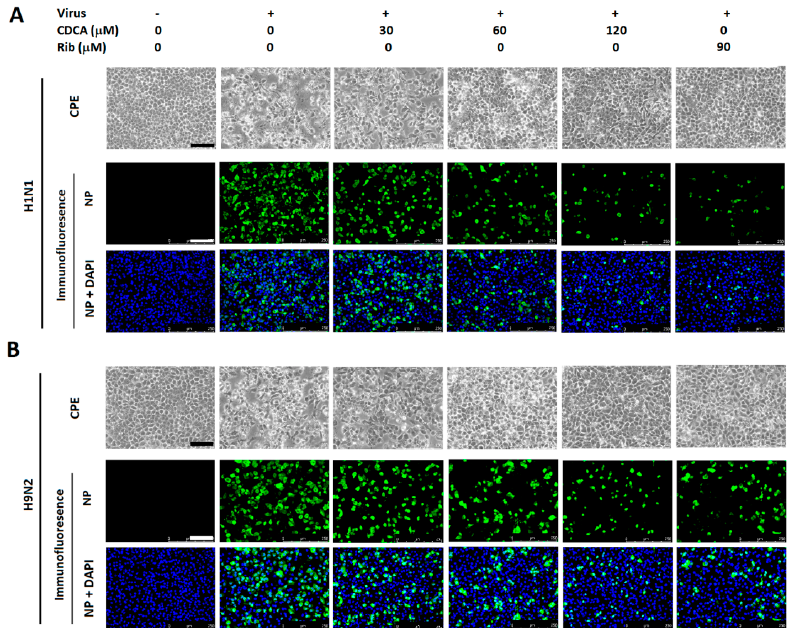
Figure 3. CDCA inhibited PR8 (H1N1) and H9N2 replication in A549 cell cultures. Cells grown in